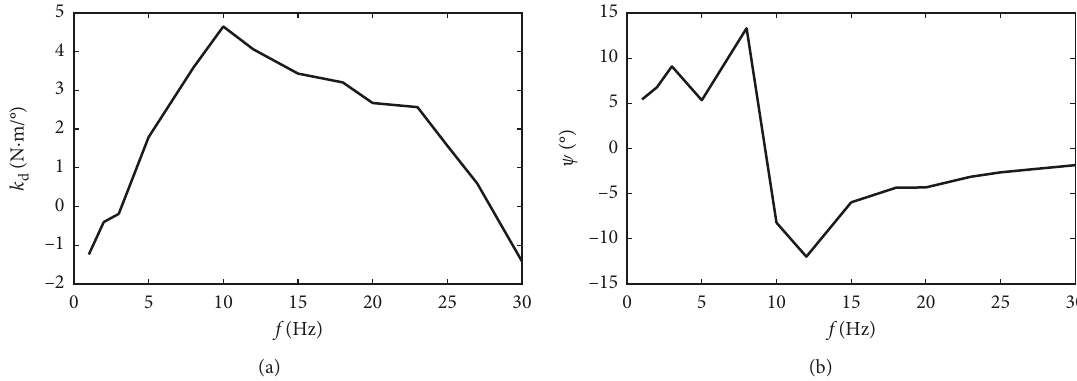
Figure 16: Model error curve with excitation amplitude of θ